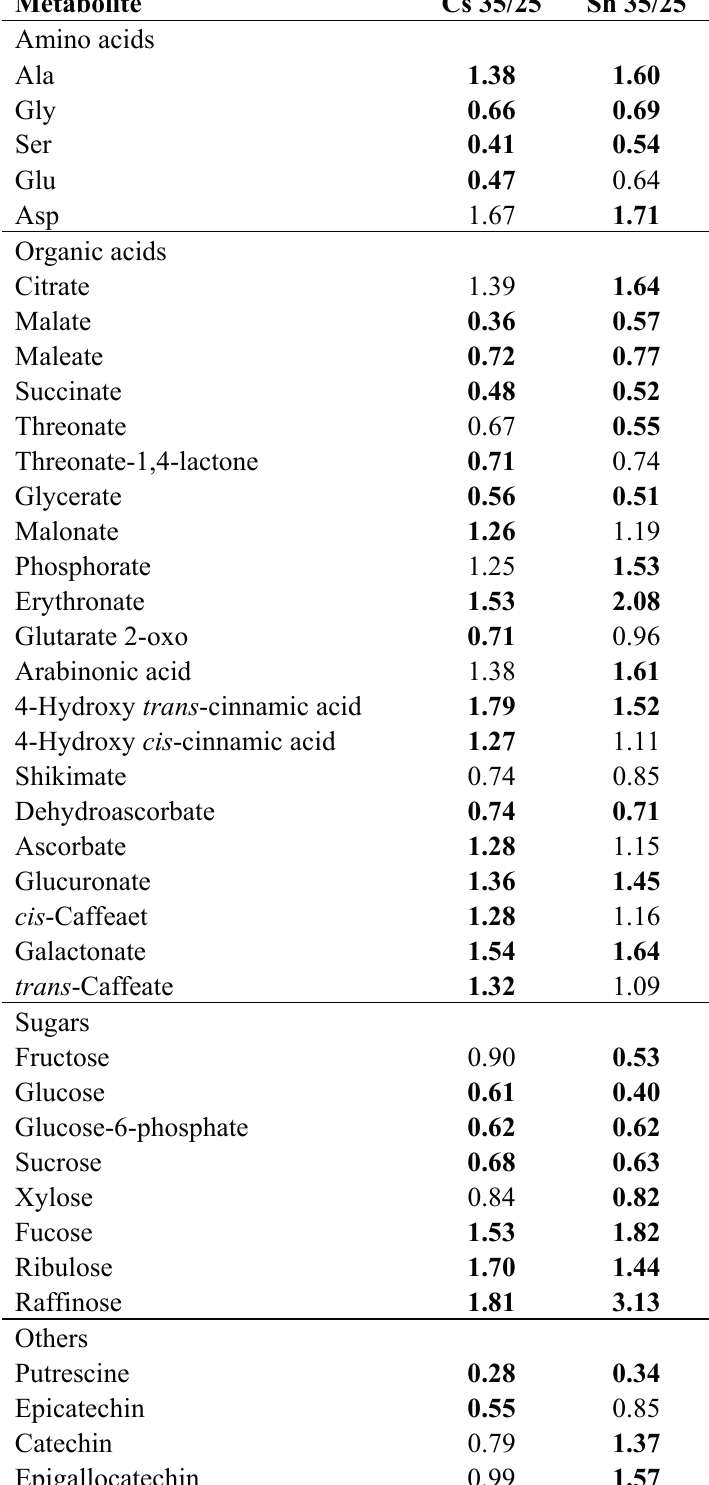
Table 1. Ratio of relative metabolite abundance at 35 and 25 °C in Shiraz (Sh) and in Cabernet Sauvignon (Cs). Only metabolites that were significantly different between the treatments in at least one of the cultivars are presented. Values are presented as fold change of mean metabolic abundance ( n = 12) in the 35 °C treated samples compared with the 25 °C treated samples. Bolded values represent significant ( p < 0.05) differences between the